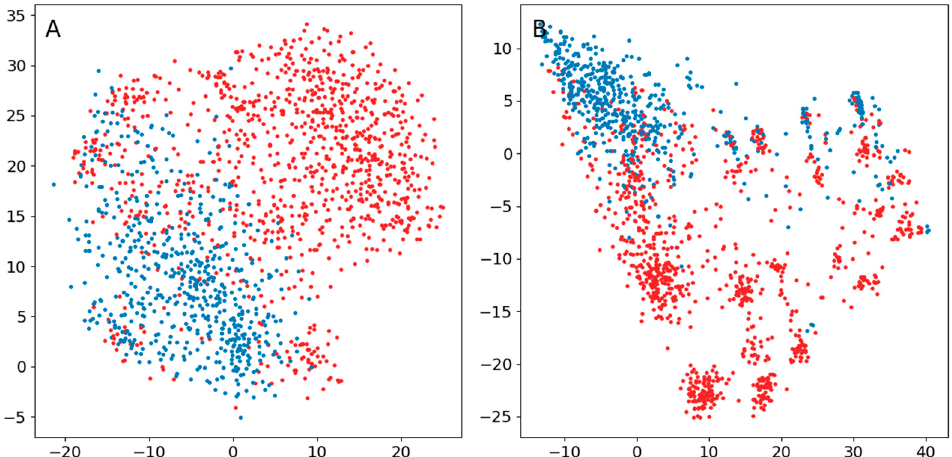
Figure A1. Comparison of training encoders using non-overlapping or overlapping time intervals as examples. EEG with a 1601 s duration representing status epilepticus, where each dot represents 1s of data and red dots indicate seizure activity. ( A ) Non-overlapping examples. The EEG was divided into 1601 unique examples by using consecutive 1 s intervals. ( B ) Overlapping examples. The whole EEG recording was loaded into CPU memory, and examples were then generated online during training by randomly selecting time positions in the recording and extracting 1 s of